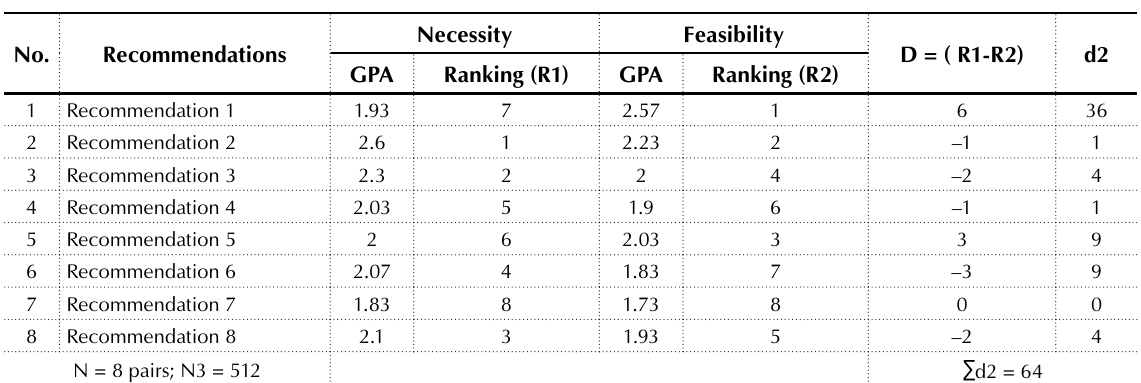
Table 7. Correlation coefficient of the necessity and feasibility of management